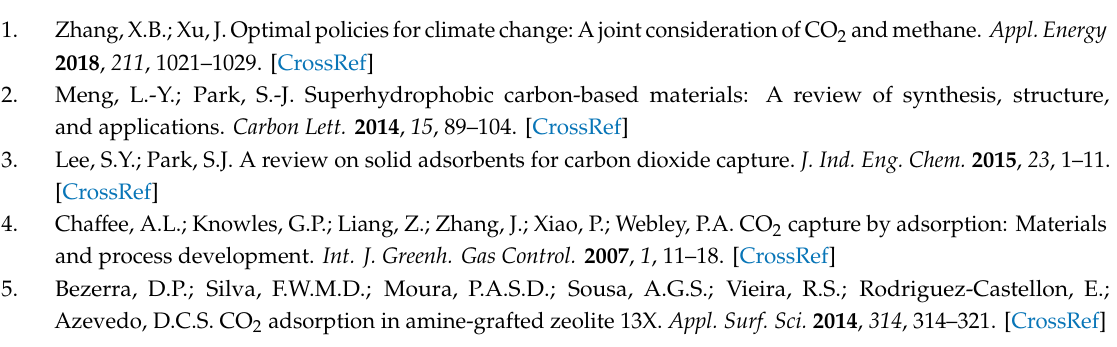
Figure S1: Nomenclature of PAN microfibers stabilized and carbonized, synthetized by electrospinning. Figure S2: TG / DTA analysis of polyacrylonitrile microfibers (PANMFs), synthesized by the electrospinning method. Reaching a temperature of 300 ◦ C the material begins to degrade thermally, therefore, in this work, an interval between 250 ◦ C and 300 ◦ C was selected. Figure S3: PAN microfibers stabilized at 280 ◦ C and carbonized at 900 ◦ C: (A) XRD analysis, the high amplitude of the peak between 5o and 35 ◦ in 2 θ indicates a high degree of amorphicity on the graphene sheets. The signal in the plane (100) is attributed to the graphitic character of the material, and (B) Raman spectroscopy analysis, which exhibit two peaks, centered at 1360 cm − 1 and 1600 cm − 1 , they are known as D and G peaks, respectively. The first peak is attributed to disordered carbon films while the second one is attributed to the presence of graphitic type ordered